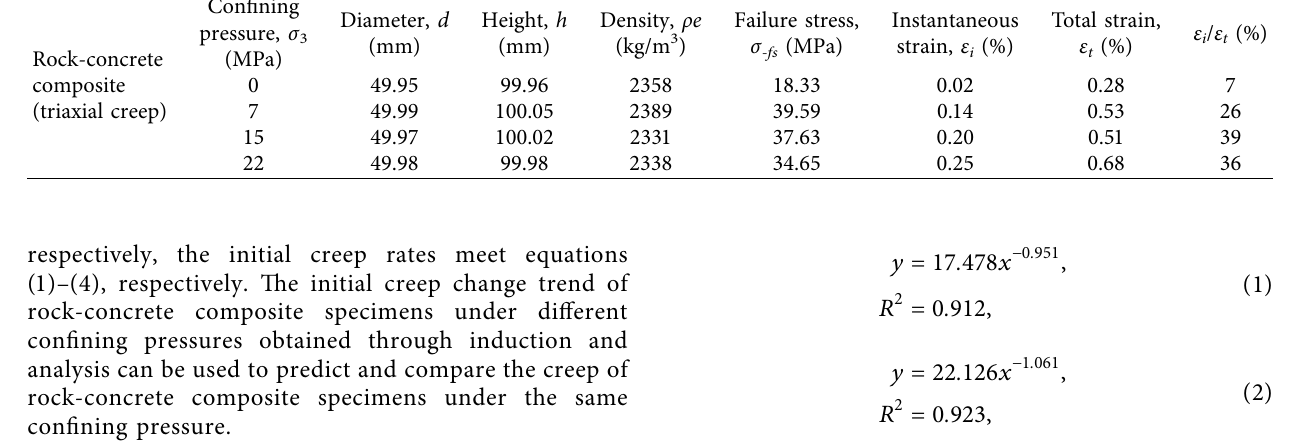
Rock-concrete composite (triaxial